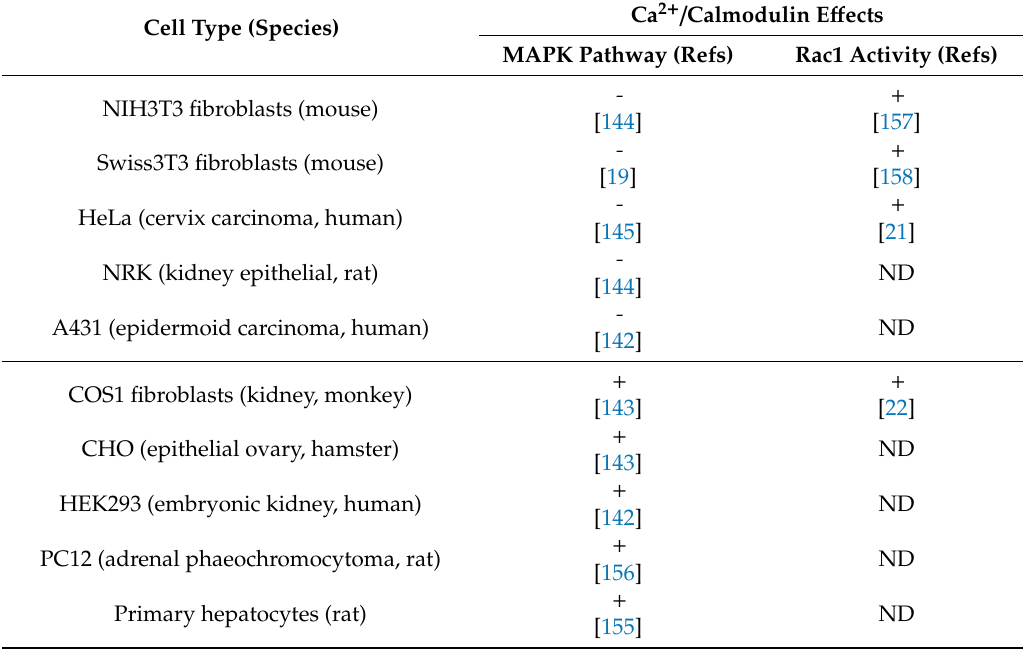
Table 2. E ff ect of calmodulin on MAPK and Rac1 activation in di ff erent cell lines. The impact of calmodulin on the activity of the MAPK pathway in di ff erent cell lines using calmodulin-specific inhibitors is shown. Some of the cell lines listed here, often in separate studies, have also been analyzed for Rac1 signalling and wherever possible, the outcome of Ca 2 + / calmodulin mediated activation of Rac1 is also listed. See text for further details. (-, inhibition; + , activation; ND, not